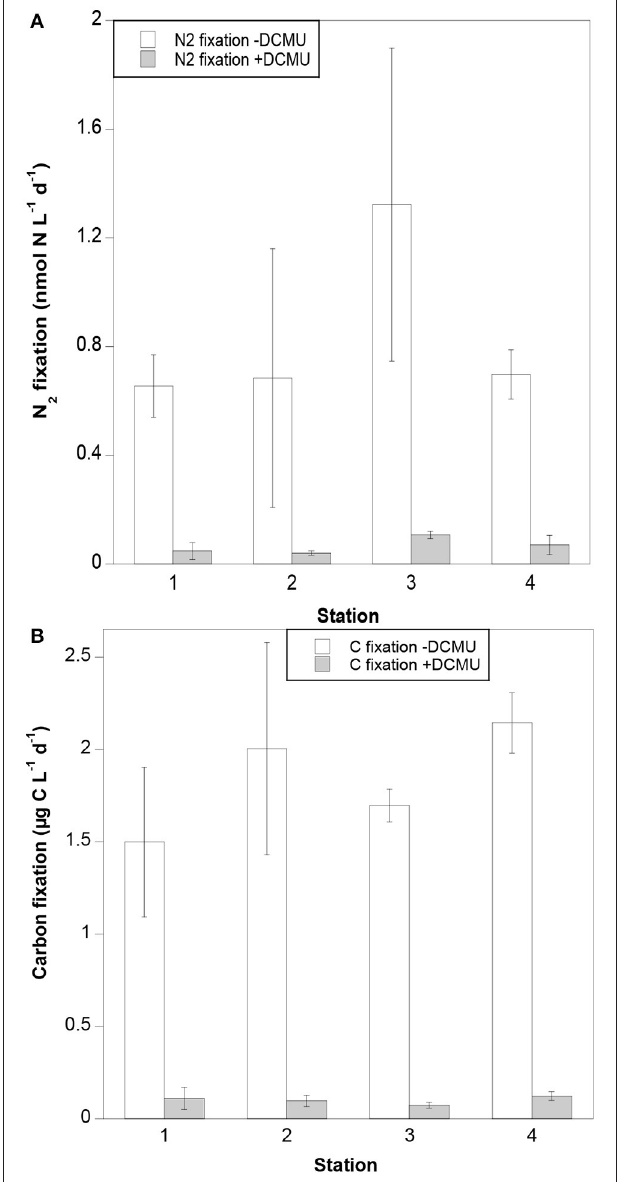
FIGURE 2 | (A) N 2 and (B) carbon fixation rates in DCMU and non-DCMU amended samples.